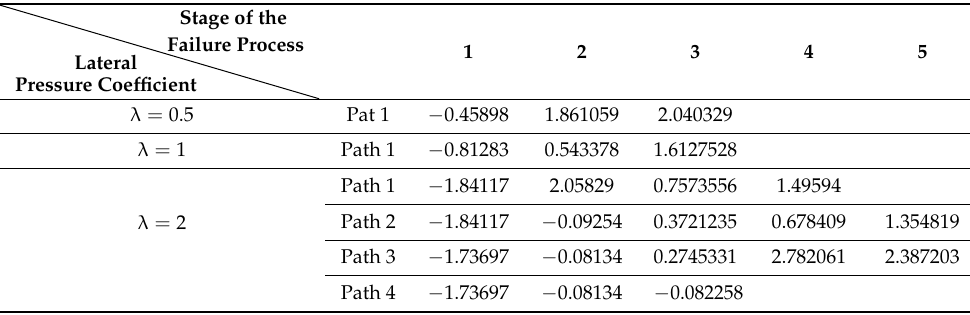
Table 5. Reliability indices of the major failure parts.